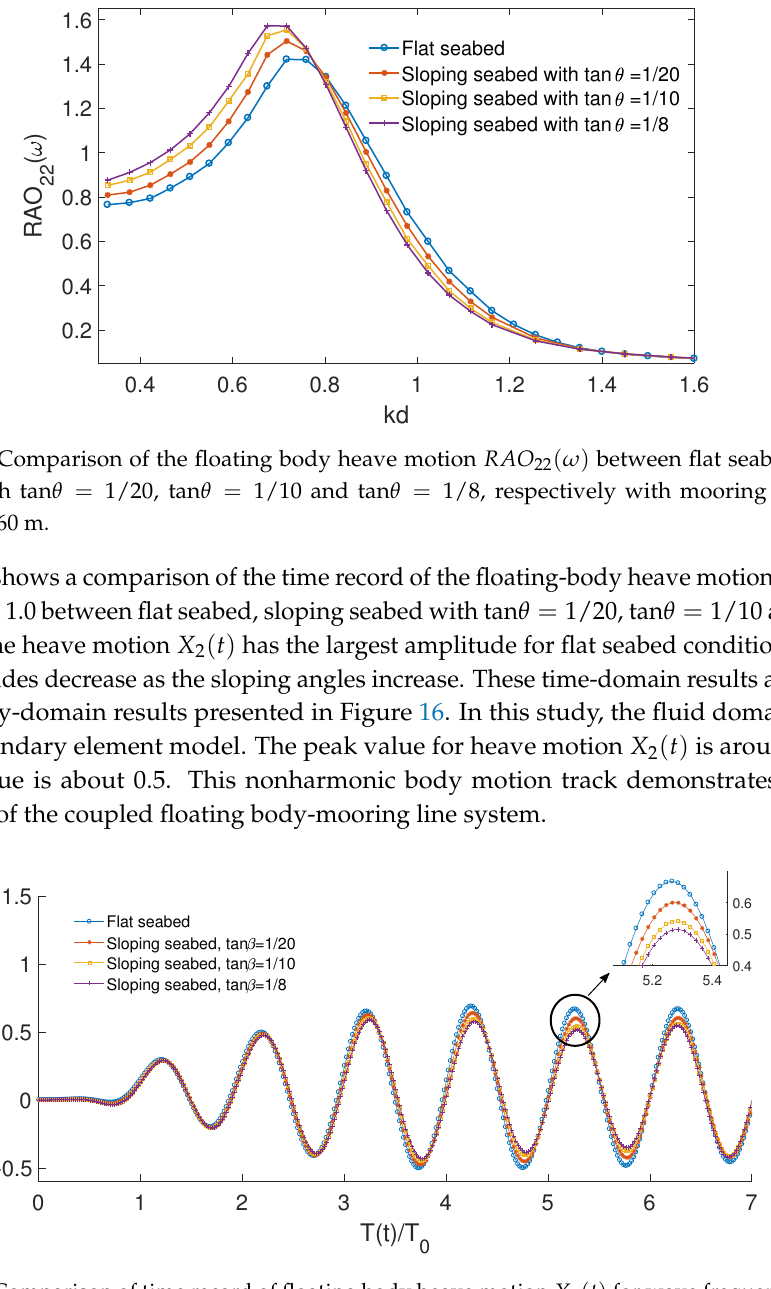
Figure 17. Comparison of time record of floating body heave motion X 2 ( t ) for wave frequency kd = 1.0 between flat seabed, sloping seabed with tan θ = 1/20, tan θ = 1/10 and tan θ = 1/8, respectively. ( t ) for wave frequency kd =